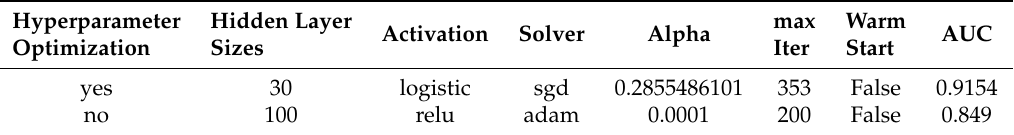
Table 6. Comparison between configurations of models for week